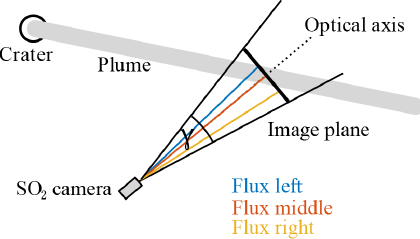
Figure 8. Map of the geometrical set-up of the measurement data set. The inclination of the plume is 38 ◦ with respect to the image plane. The positions in the FOV used for the flux determination are coloured.